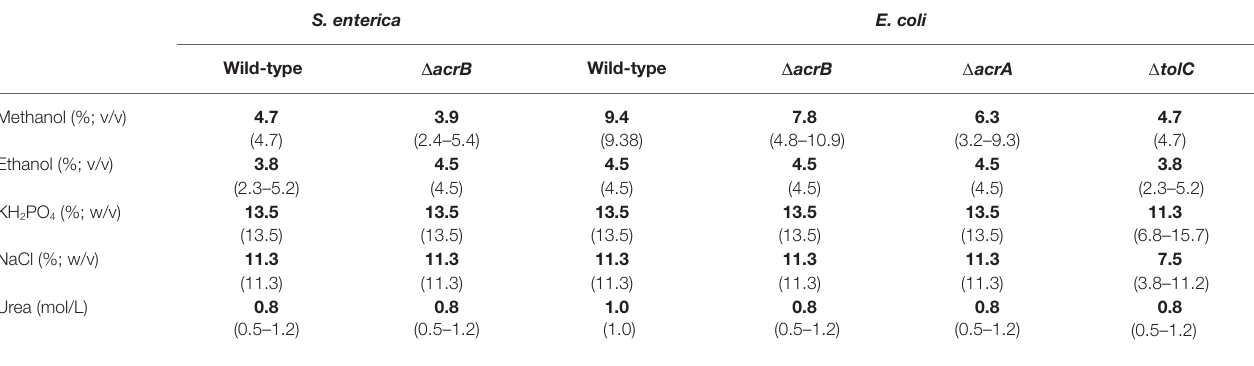
TABLE 1 | Mean MIC values (bold) for chemicals including upper and lower limits of 95% CIs (in brackets) of the respective Salmonella enterica and Escherichia coli strains after 24 h incubation at 37°C. S.